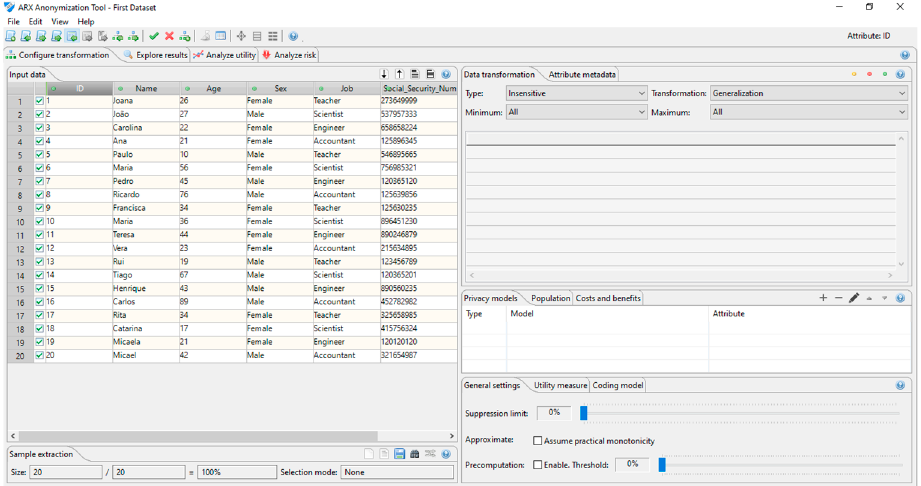
Figure 1. ARX Data Anonymization interface.